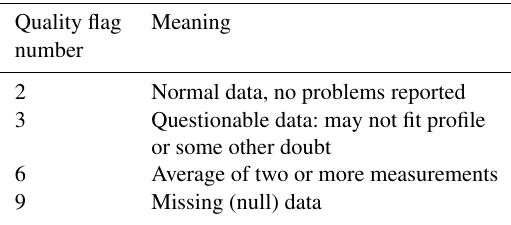
Table 2. Quality flag meaning. Quality flag